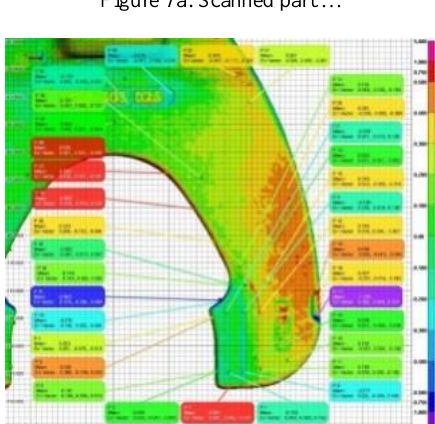
Figure 7a: Scanned part …